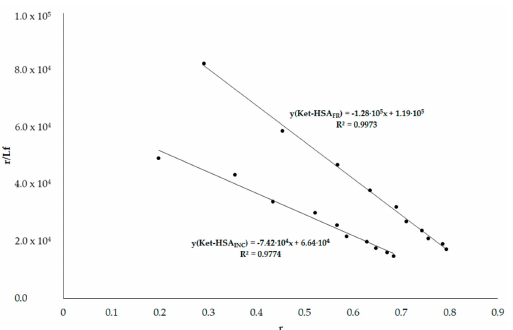
Figure 11. Scatchard curve for Ket–HSA FR and Ket–HSA INC systems; λ ex 295 nm. Based on the Scatchard curves, the association constants values calculated for Ket–HSA FR and − 1 · − 1 · Ket–HSA INC systems are 13.2 × 10 4 mol L and 18.1 × 10 4 mol L, respectively. Figure 11 presents Scatchard curves in the same systems as above, but at the excitation wavelength λ ex 295 nm. Calculated association constant values for Ket–HSA FR and Ket–HSA INC systems at λ ex 295 nm are − 1 · − 1 · 12.80 × 10 4 mol L and 7.42 × 10 4 mol L, respectively, and the influence of aggregation /